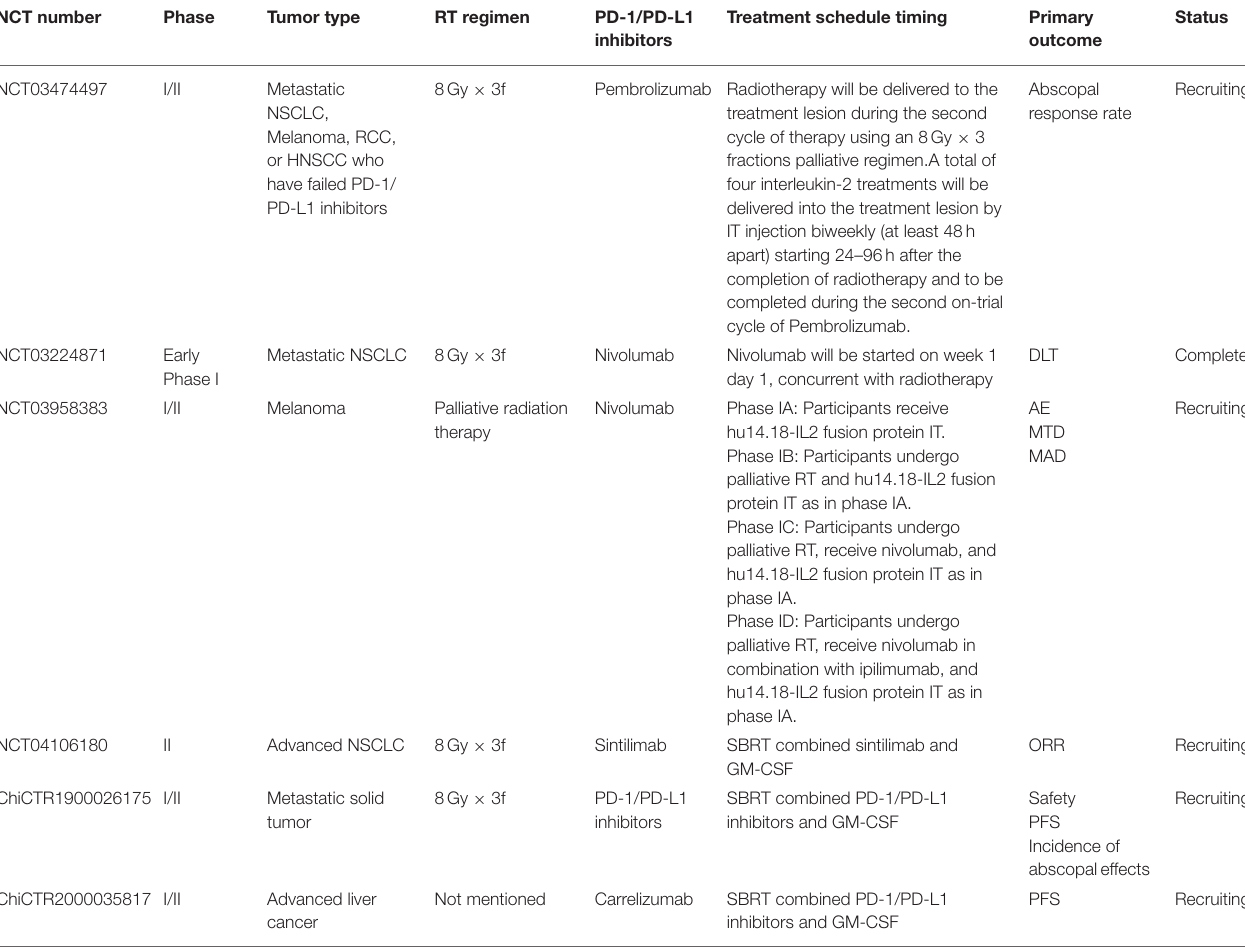
TABLE 3 | Trials testing radiotherapy in combination with PD-1/PD-L1 and cytokines (IL-2 or GM-CSF). NCT